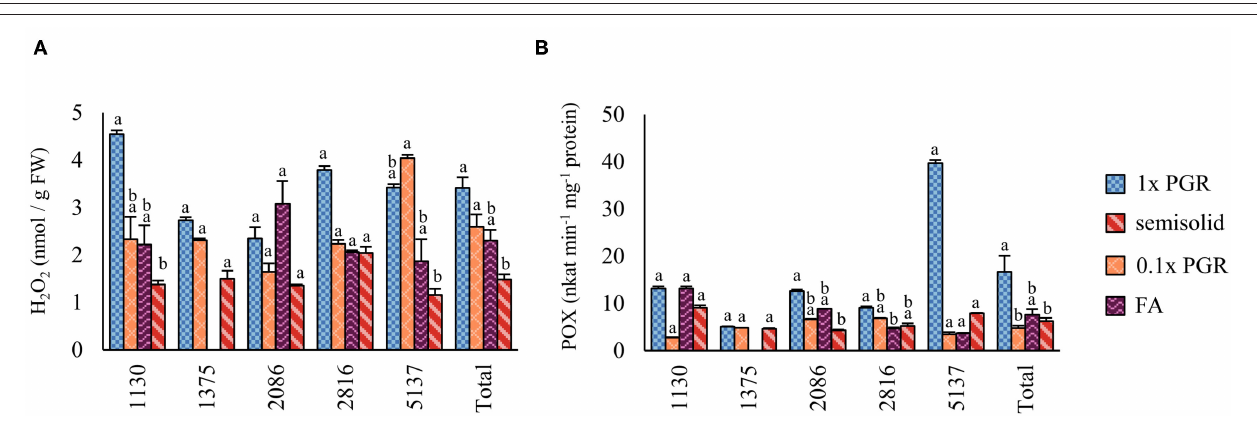
FIGURE 1 | Proliferation rates between different treatments in Experiments I (A) , II (B) , and IV (C) . 1x plant growth regulator (PGR), 0.5x PGR, and 0.1x PGR stand for the concentrations of plant growth regulators 2,4-dichlorophenoxyacetic acid (2,4-D) and 6-Benzylaminopurine (BA) in suspension cultures. Mean values of growth factors (fresh weight (FW) after 1 week/inoculum FW) are presented with the standard error of the mean (SEM). No significant differences were found between the treatments within each experiment.